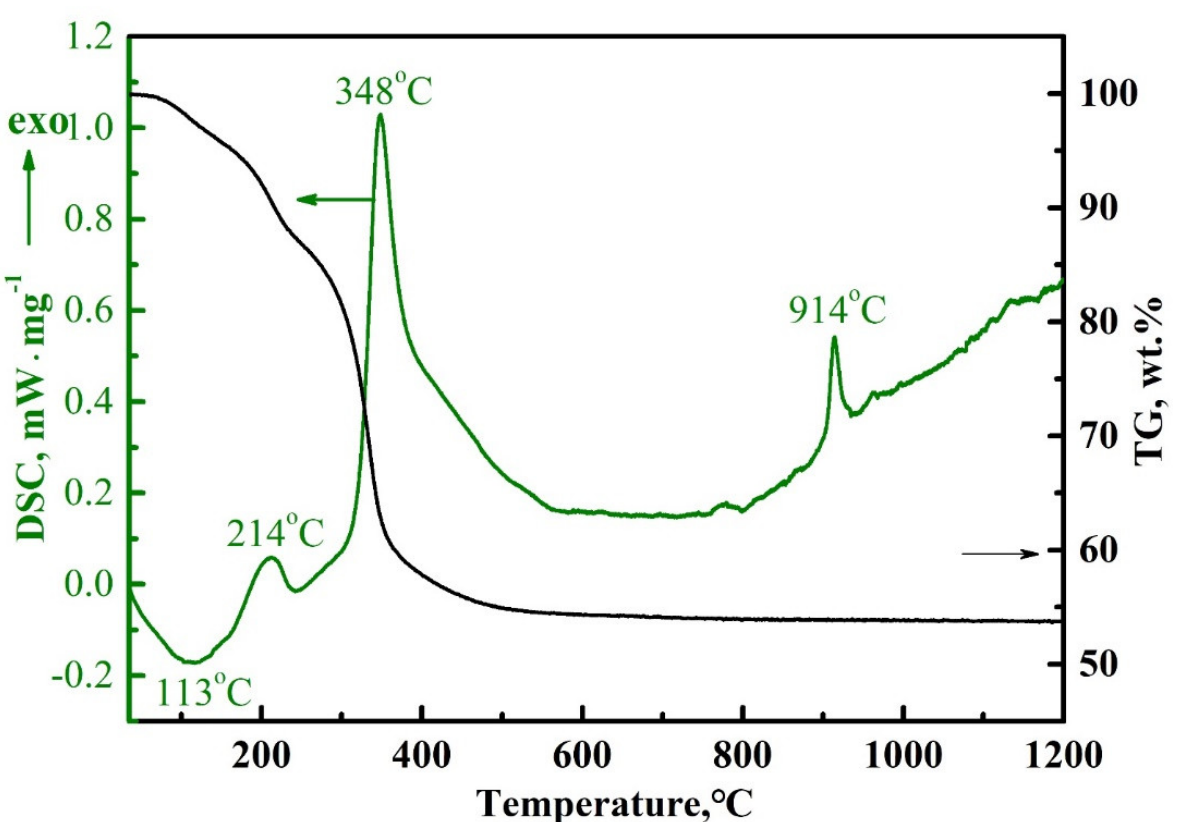
Figure 2. DSC-TGA traces of the synthetic egg-yellow mixture powder.